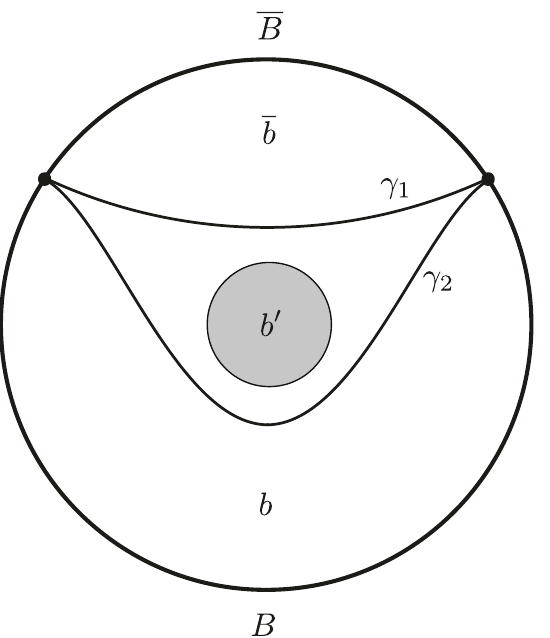
Figure 4 . Black hole setup in which we derive a contradiction from the QES prescription. Prac- tically identical to the setup of figure 1, this setup replaces the dustball with a black hole, and its boundary regions B and B are now